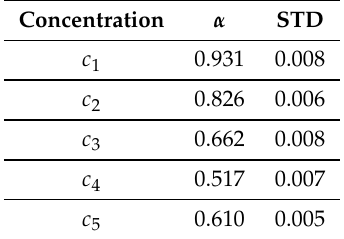
Table 2. α parameters for different concentrations of mucin based on the fitting function presented in Equation